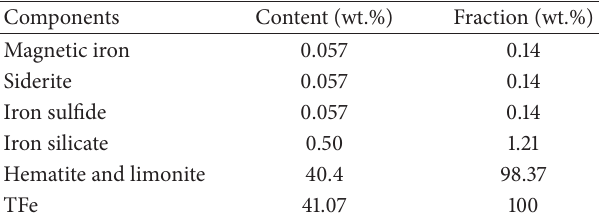
Table 3: Iron distribution of the hematite